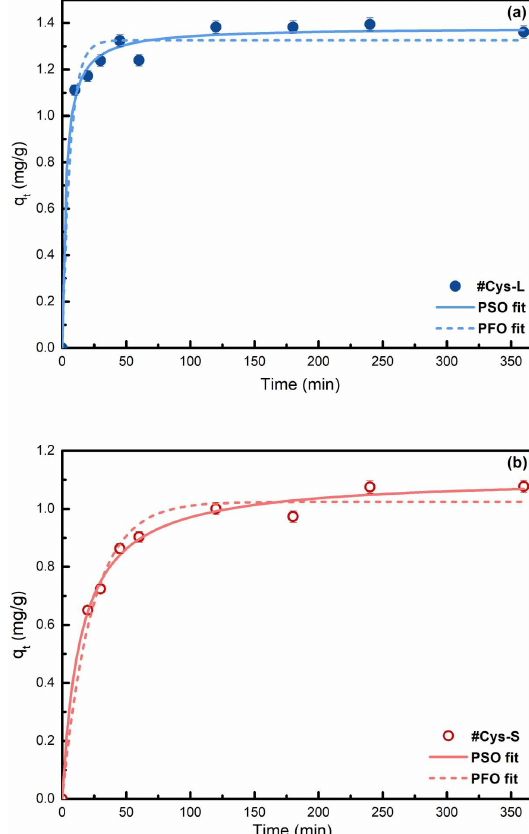
Figure 7. FTIR spectra of the nanopowder samples after loading with Pb(II) at pH 3. The shift of the S–S stretching band from 540 cm -1 to around 516 cm -1 indicates that the lead adsorption occurs through the thioether group of cystine at this pH region.